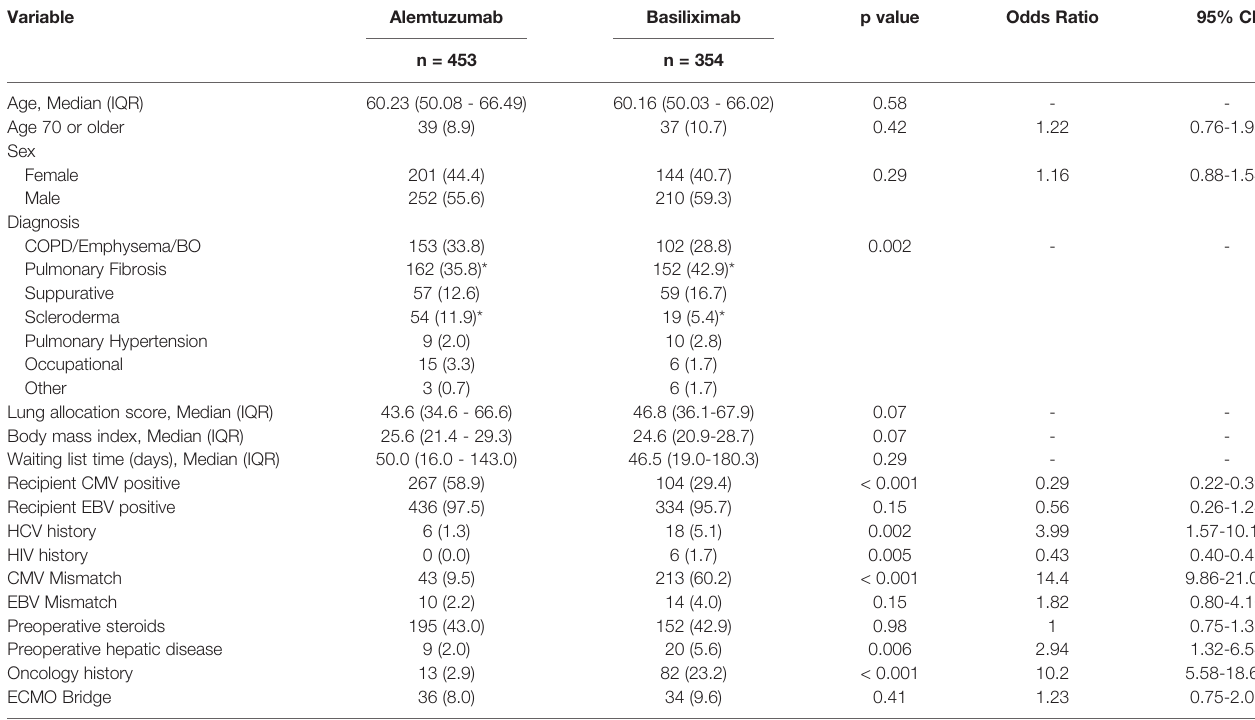
TABLE 1 | Patient demographic and preoperative